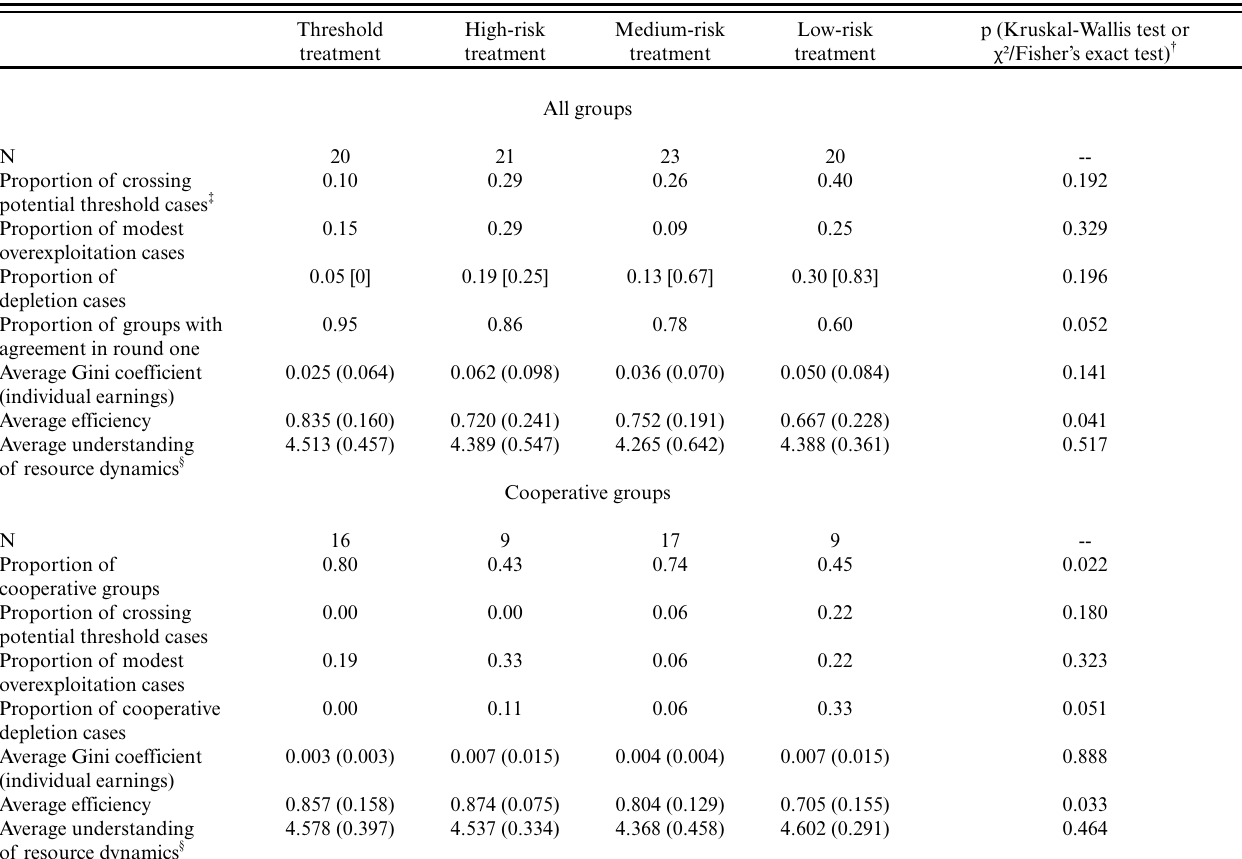
Table 3 . Comparison of proportions and averages across the four treatments for all groups and cooperative groups